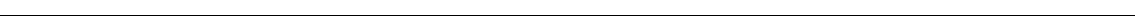
Fig. 3 NF- κ B pathway is responsible for Morgana dependent cancer cell metastasis. a , b Luciferase assays of AP-1 (left) and NF- κ B (right) activity in a MDA-MB-231 infected with an empty vector (EMPTY) or shRNAs targeting Morgana (shMORG1 and shMORG2) and b MCF7 infected with an empty vector (EMPTY) or overexpressing Morgana (MORGANA). Cells were transfected with an AP-1 or NF- κ B luciferase reporter or a control vector. c , d Gene expression analysis by Real-time PCR of NF- κ B target genes in c MDA-MB-231 EMPTY or shMORG1 and shMORG2, and d MCF7 EMPTY or MORGANA, treated or not with 10nM TNF α for 4 h. e The top 10 gene ontology (GO) terms by enrichment P-value among the down-regulated genes obtained in a microarray analysis of MDA-MB-231 cells silenced for Morgana compared to control cells. The stars indicate signatures NF- κΒ related. f Immunoblotting of I κ B α , Morgana and Vinculin in MDA-MB-231 cells EMPTY or shMORG1 and shMORG2 in combination or not with I κ B α shRNA. g Luciferase assays of NF- κ B activity in MDA-MB-231 cells described in f transfected with a NF- κ B luciferase reporter or control vector. h Representative pictures of lungs of NSG mice after 4 weeks from the intravenous injection of MDA-MB-231 cells described in f . i Quanti fi cation of metastasis colonies in the lungs of mice described in h ( n = 6 NSG mice per group). j Tumor weight 5 weeks after subcutaneous injection of cells described in f ( n = 3 NSG mice per group). k , l Representative haematoxylin and eosin stained sections k and percentage of lung metastatic area l . Each data point represents one mouse ( n = 3 NSG mice per group). Data are the results of three independent experiments. Bars in graphs represent standard errors (** p < 0.01; *** p <